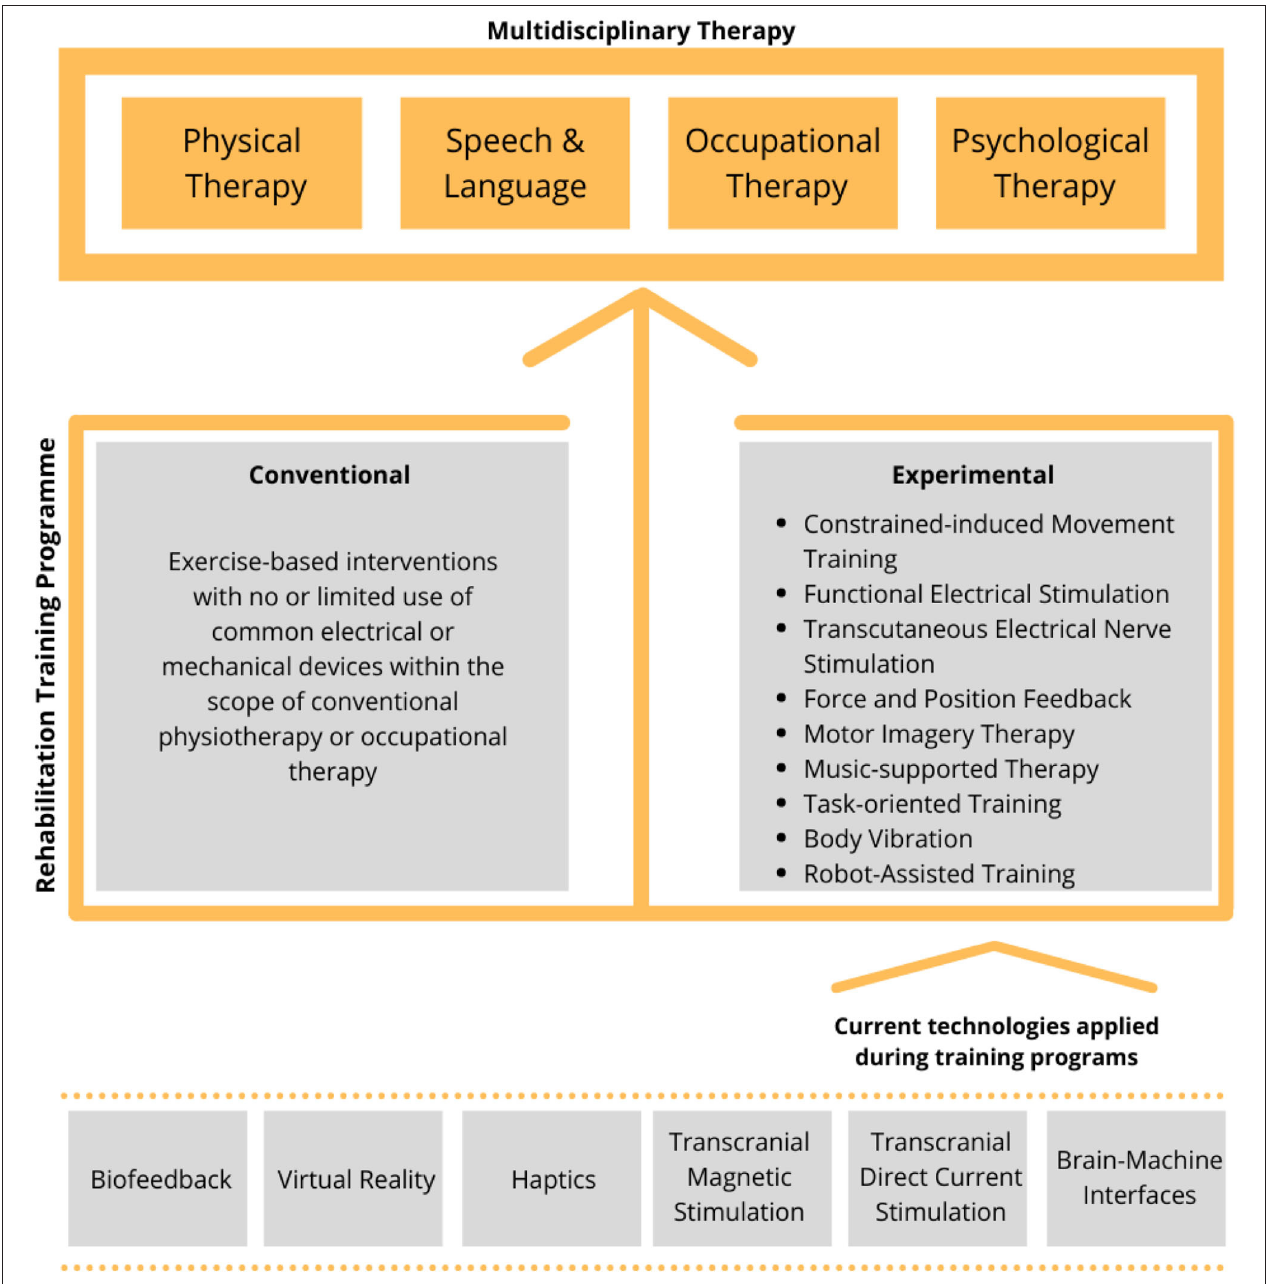
FIGURE 1 | Outline of the current training approaches and technologies used in the rehabilitation. A rehabilitation training program (middle) is used to support the multidisciplinary therapy (top). Rehabilitation training can be either conventional or experimental and the latter being found on one or more available technologies